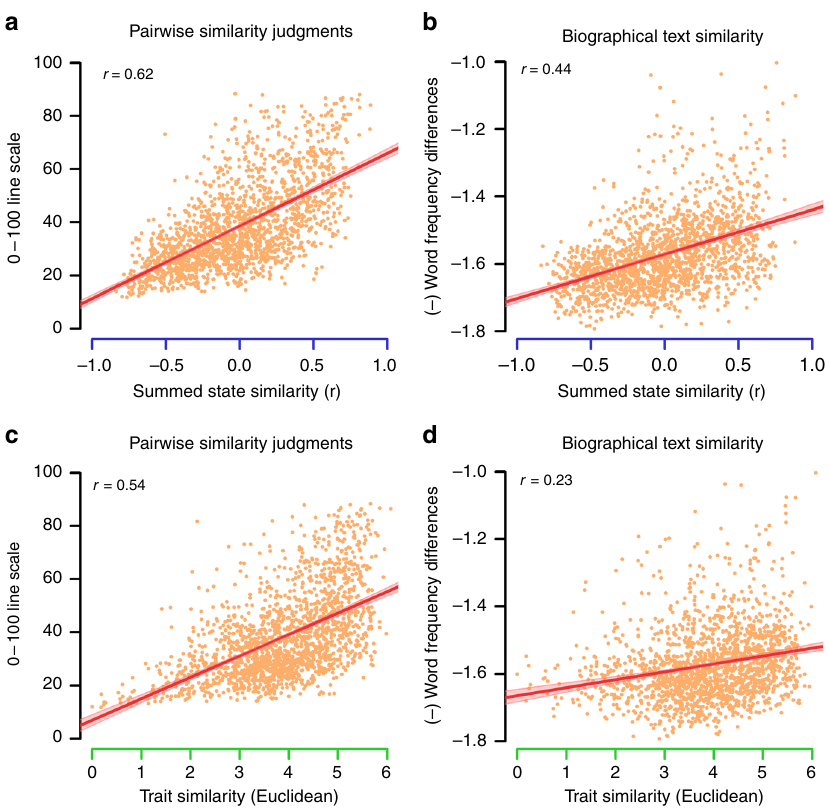
Fig. 3 Comparing the summed state and trait accounts. a The correlation between summed state similarity and averaged pairwise similarity ratings. b The correlation between summed state similarity and the semantic similarity of biographic text. c The correlation between trait similarity and averaged pairwise similarity ratings. d The correlation between trait similarity and the semantic similarity of biographic text. Axis colors correspond to the analysis schematic (Fig. 2): summed states (blue), traits (green), and interpersonal similarity measure (black). In all cases, summed state account provides a better description of person perception than the trait account. The shaded regions in the scatterplots represent 95% con fi dence intervals around the best fi t lines